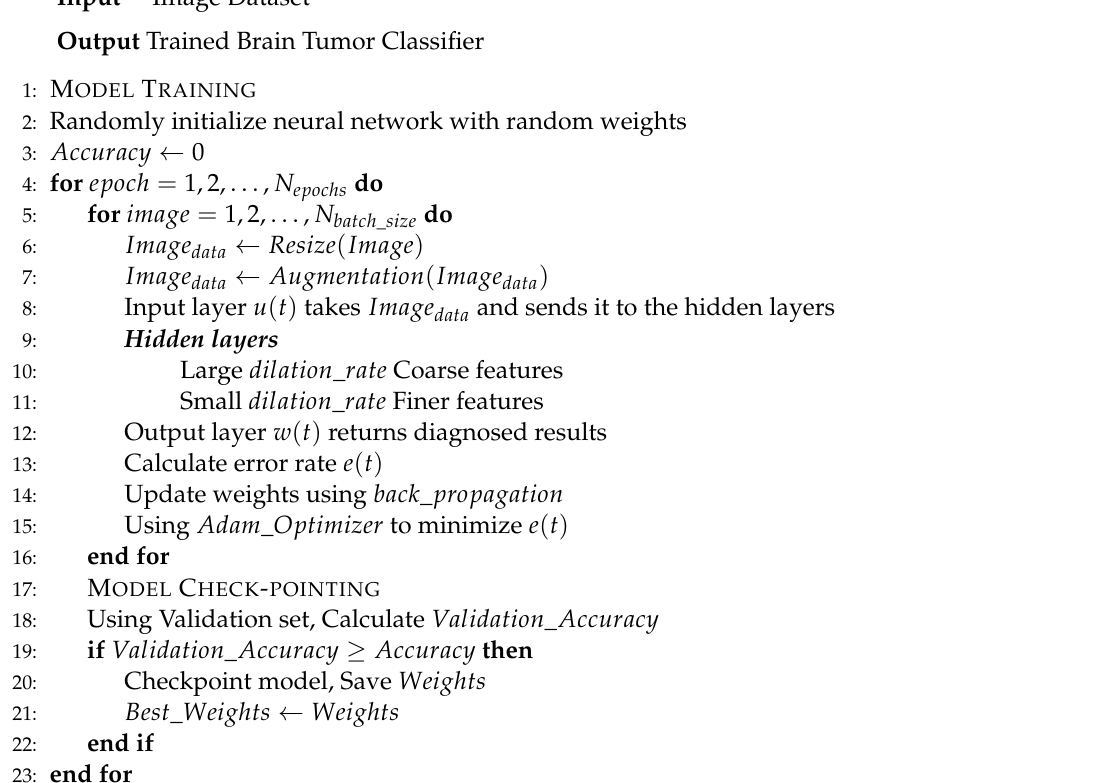
Algorithm 2 Dilated CNN Classifier